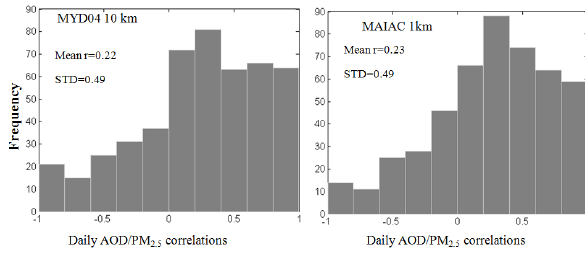
Fig. 4. Frequency distribution of daily AOD vs. PM 2 . 5 correlations Figure 4. Frequency distribution of daily AOD vs PM 2.5 correlations for MYD04 (left) and for MYD04 (left) and MAIAC MAIAC (right).